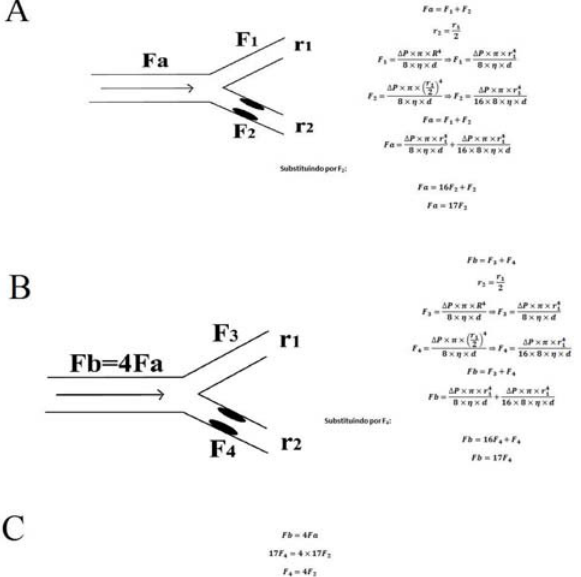
Fig. 1 - Fa, Fb- fluxo total, F , F , F , F - Fluxo no segmento 1 2 3 4 e r - raio do segmento arterial; ∆ P- diferença de arterial; r 1 2 pressão em 2 pontos; R- raio (genérico); η - viscosidade; d- comprimento do segmento. A - Cálculo do fluxo total em função do fluxo no ramo com estenose; B - Cálculo do fluxo total em função do fluxo no ramo com estenose; C - Cálculo do fluxo dos ramos estenóticos em cada situação de fluxo